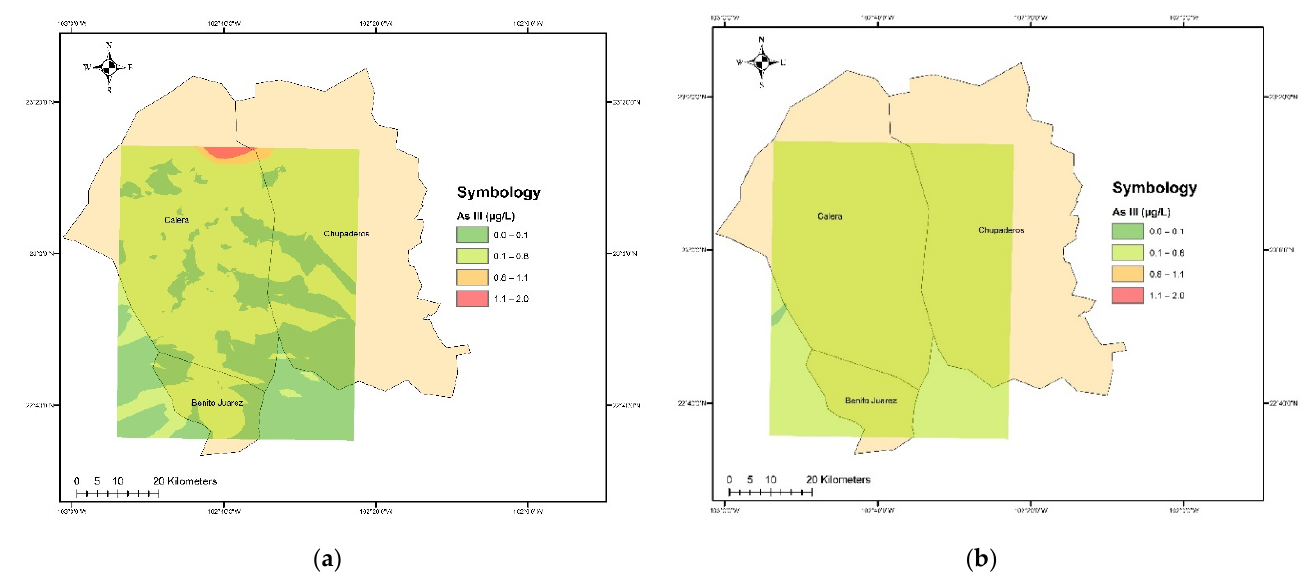
Figure 5. As (III) concentration in groundwater of the study area: ( a ) 2015; ( b )